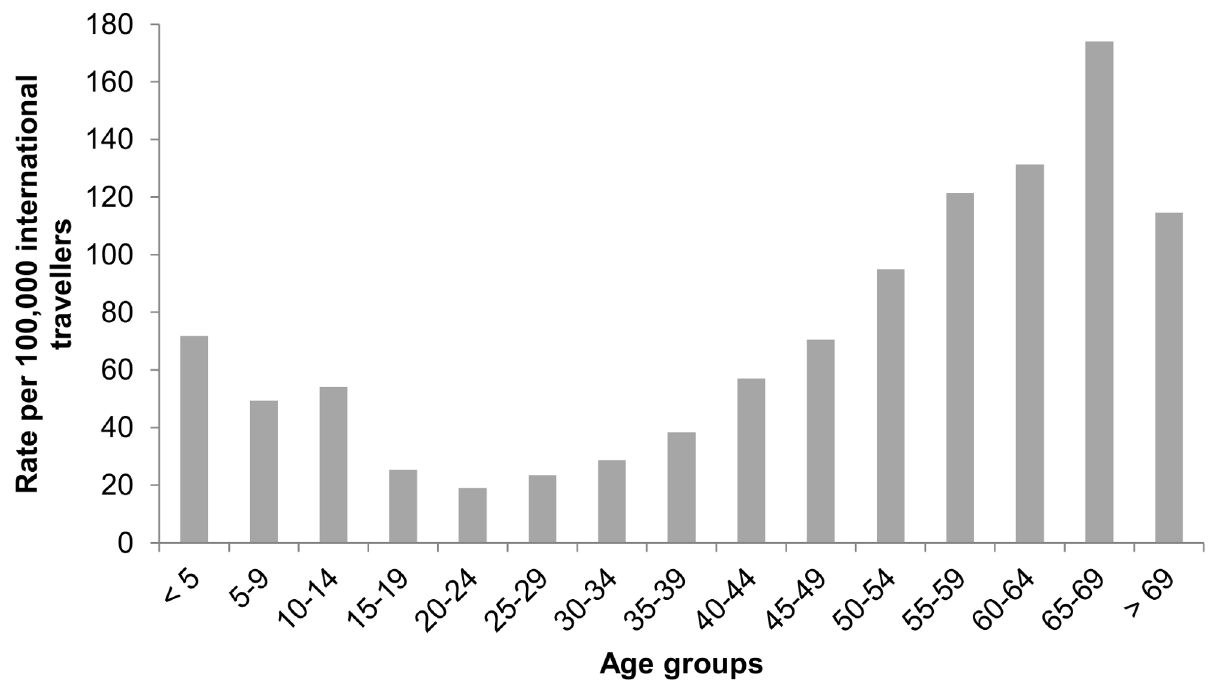
Figure 4. Rates of Plasmodium infection per age group for imported malaria cases in Ontario, Canada (1990–2009) *. *Rates per 100,000 international travellers estimated based on total non-permanent residents travelling to Ontario (1990–2009)